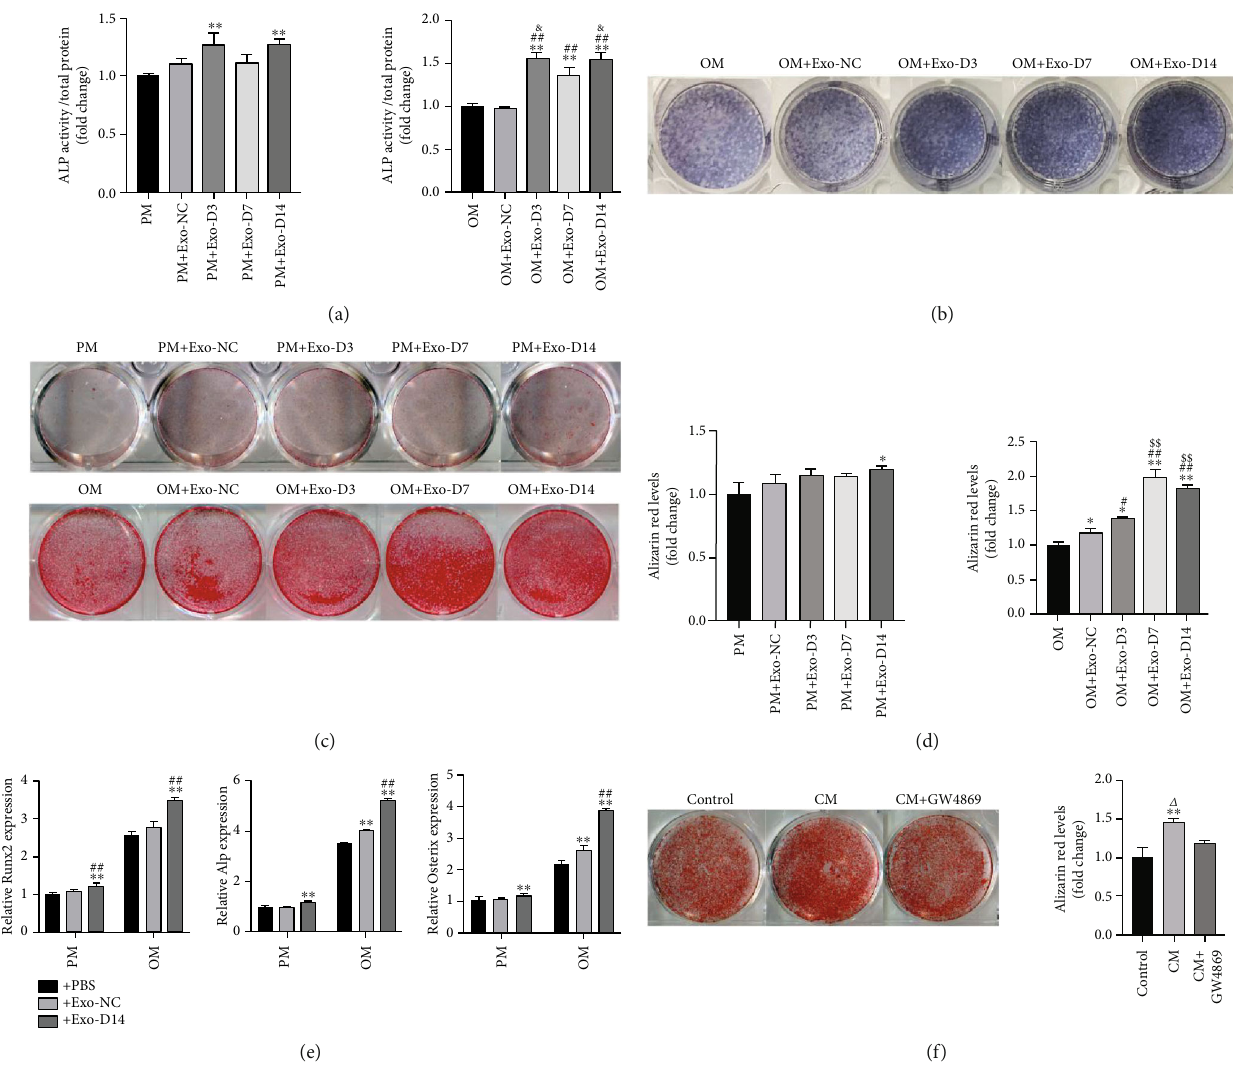
Figure 4: hPDLSC-derived exosomes enhanced the osteogenic di ff erentiation of rBMSCs. (a) Alkaline phosphatase (ALP) activity normalized against the total protein content. N = 3 /group. (b) ALP assays of BMSCs after incubation with 50 μ g/mL exosomes from PDLSCs after 0, 3, 7, and 14 days of osteoinduction at day 7. (c) Alizarin red staining (ARS) of BMSCs after incubation with 50 μ g/mL exosomes from PDLSCs after 0, 3, 7, and 14 days of osteoinduction at day 14. (d) Semiquantitive analysis of alizarin red staining (ARS). N = 3 /group. (e) Expression of RUNX2, ALP, and Osterix in rBMSCs cultured with or without exosomes at 7 days. N = 3 /group. (f) Alizarin red staining (ARS) of BMSCs after being cocultured with conditioned medium (CM) of PDLSCs treated with or without GW4869. N = 3 /group. PM: proliferation medium; OM: osteogenic induction medium; ∗ p < 0 : 05 compared with the control group (PM/OM/control group); ∗∗ p < 0 : 01 compared with the control group; # p < 0 : 05 compared with the Exo-NC group; ## p < 0 : 01 compared with the Exo-NC group; $ p < 0 : 05 compared with the Exo-D3 group; & p < 0 : 05 compared with the Exo-D7 group. △ p < 0 : 05 compared with the GW4869